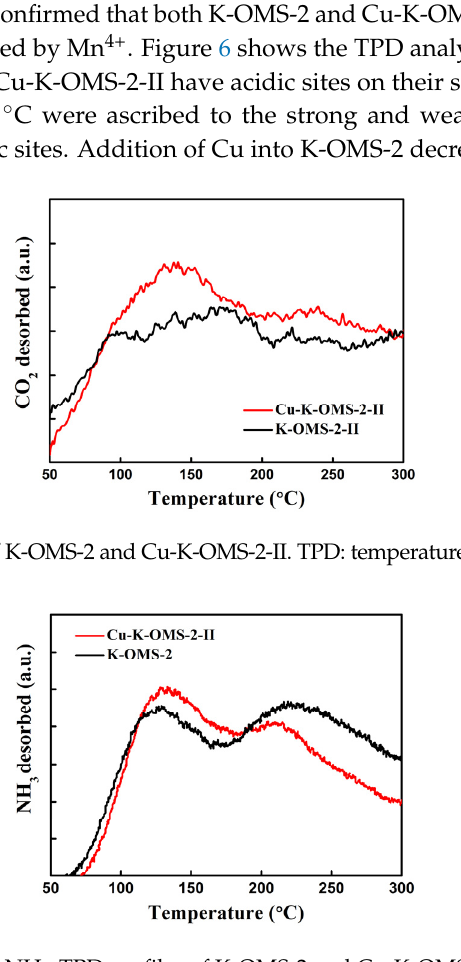
Figure 6. NH 3 -TPD profiles of K-OMS-2 and Cu-K-OMS-2-II.